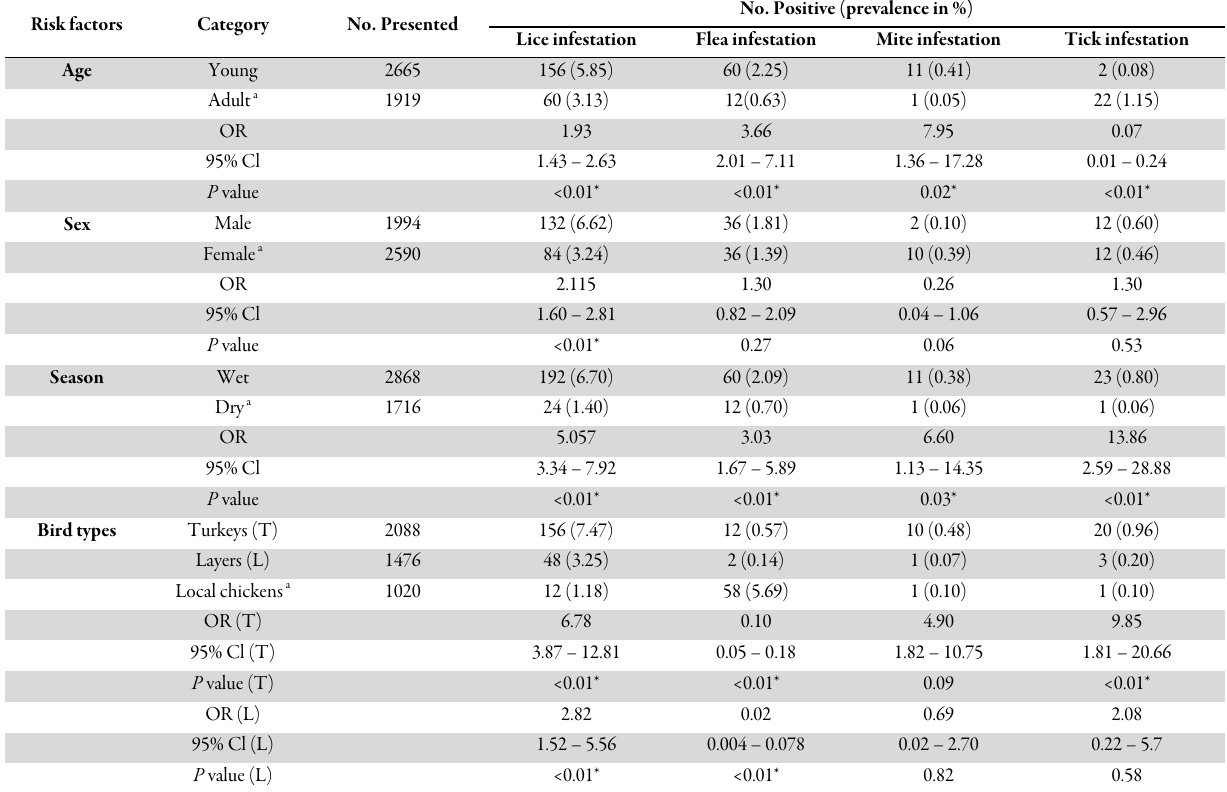
Table 3. Prevalence and association between hypothesized risk factors with ectoparasitic infestations diagnosed among 4,584 avian species presented at the major Veterinary Hospitals in Osun State from